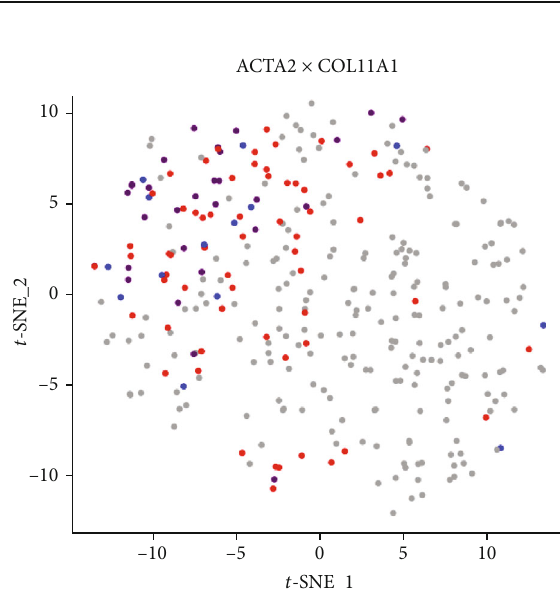
Figure 2: t -SNE plot illustrating the expression of ACTA2 and COL11A1 in individual hASCs. Each dot on the plot represents an individual cell. Cells expressing ACTA2 are represented as blue dots while cells expressing COL11A1 are represented as red dots. Cells expressing both are colored purple while the grey dots represent cells that express neither of the selected genes. The data shows the selected genes being predominantly expressed in cluster 1